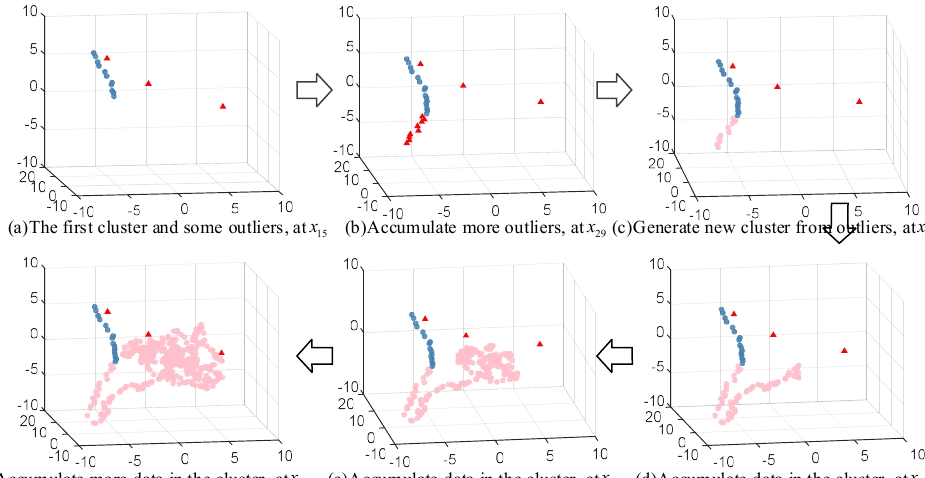
Figure 5. Illustrations of online dynamic clustering for TE process.